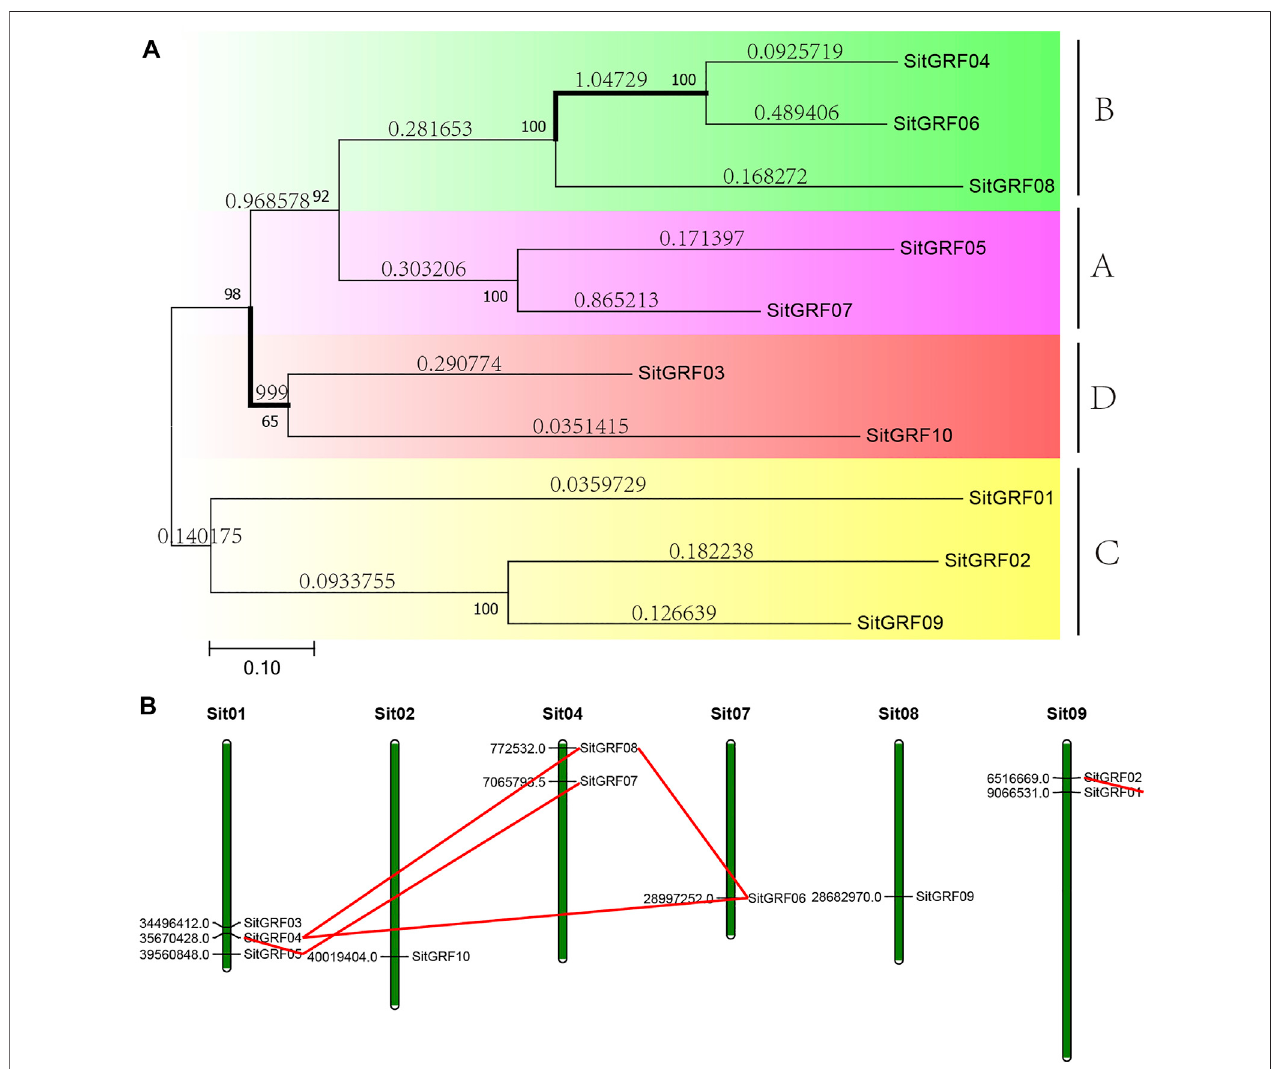
FIGURE5| PhylogenetictreeandchromosomelocationoftheGRFfamilyoffoxtailmillet. (A) PhylogeneticanalysisoffoxtailmilletGRFproteinsusingMEGA7.0via the neighbor-joining (NJ) method with 1000 bootstrap replicates. Bold branches suggest that they may be positively selected. (B) Chromosomal distribution and gene duplications of foxtail millet GRF genes. Green bars represent chromosomes of foxtail millet. The putative whole genome duplication (WGD) or segmental duplication genes are linked by a red line.